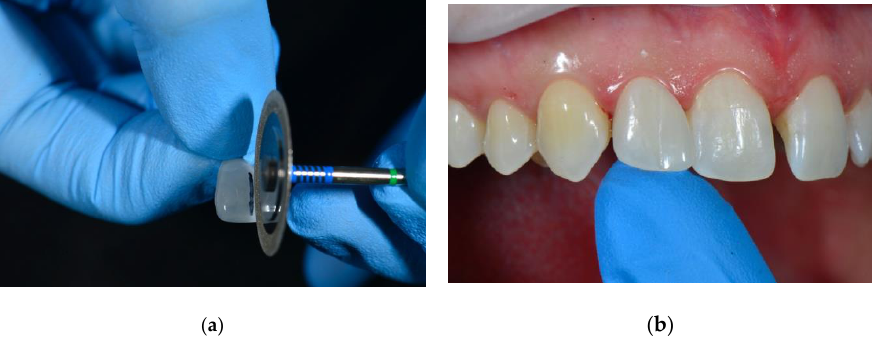
Figure 6. ( a ) A diamond separating disc is used to cut the veneer; ( b ) the sectional veneer clicks into place. into